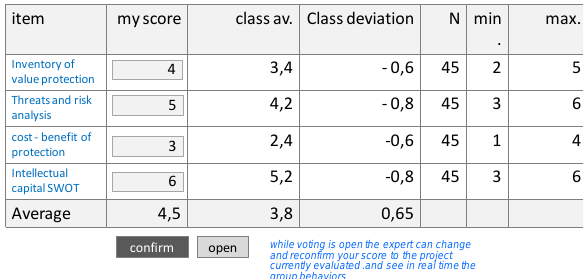
Figure 4. Items to evaluate by expert(teacher) in “guess the score”.